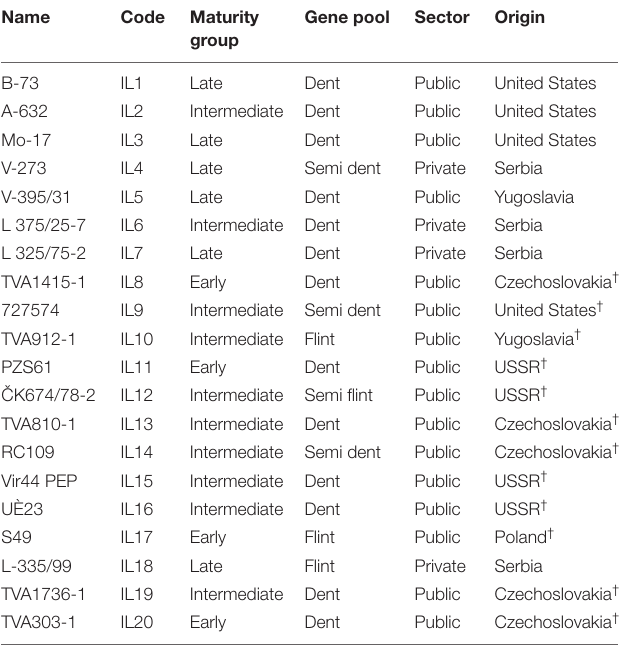
† Indicates the MRIZP Gene bank accessions for which exact country of development could not be determined so country of collection was listed instead. Based on our knowledge or as reported in past studies (see section “Materials and Methods” for more details) the studied genotypes can be classified as susceptible (ILs 1-5) or tolerant (ILs 6-20).